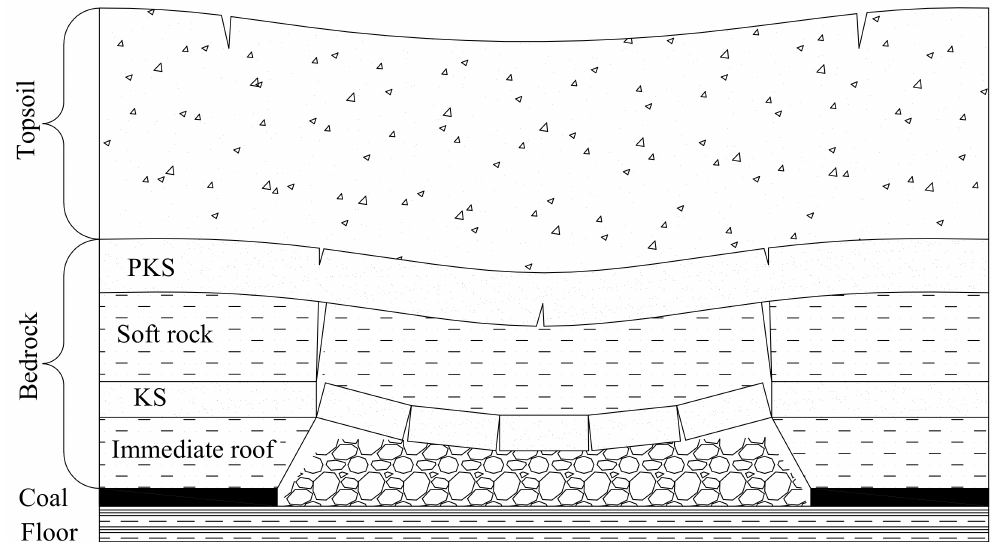
Figure 1. Common type of overburden strata on the coal seam (the upper most KS is defined as